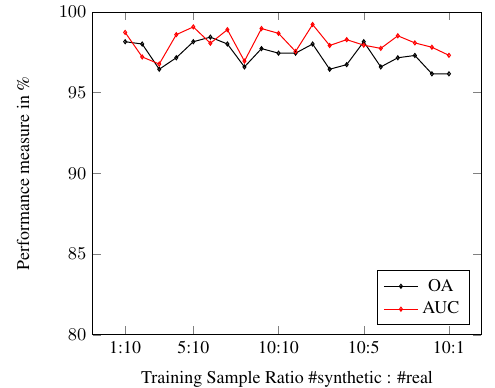
Figure 10. Overall accuracy and ROC AUC of the traffic sign detector trained with different ratios between synthetic and real samples. Tests are done on real samples only.